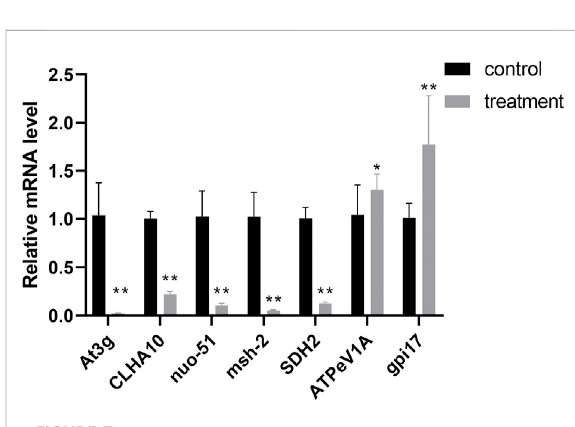
FIGURE 7 Correlation of expression level analyzed by qRT-PCR with dataobtainedusingRNA-Seqplatform.Thedatarepresentmean± SD (n = 4). *, p < 0.05; **, p <